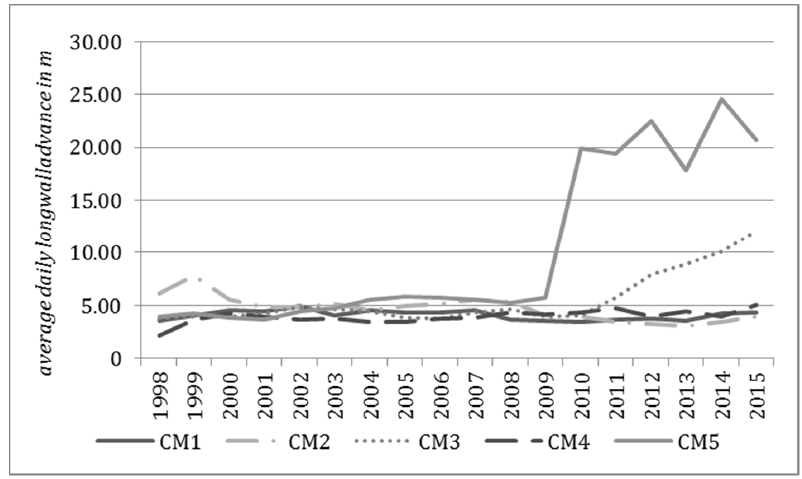
Figure 8. Average daily longwall advance in examined hard coalmines over the period 1998–2015 (m). Source: own work. Source: own